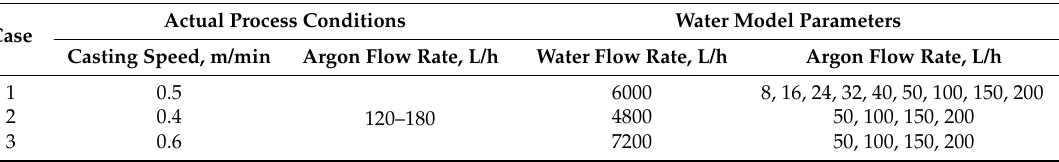
Table 1. Experimental scheme of the water model and process conditions.